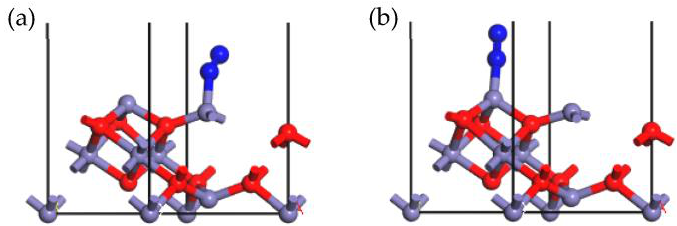
Figure 8. Stable adsorption configurations of N 2 onto Fe tet site ( a ), Fe oct site ( b ) of the γ -Fe 2 O 3 (111) surface (N, blue; Fe, purple; O, red). Table 3. The parameters of optimized configurations of the γ -Fe 2 O 3 (111) surface-adsorbed N 2 mol- ecule.